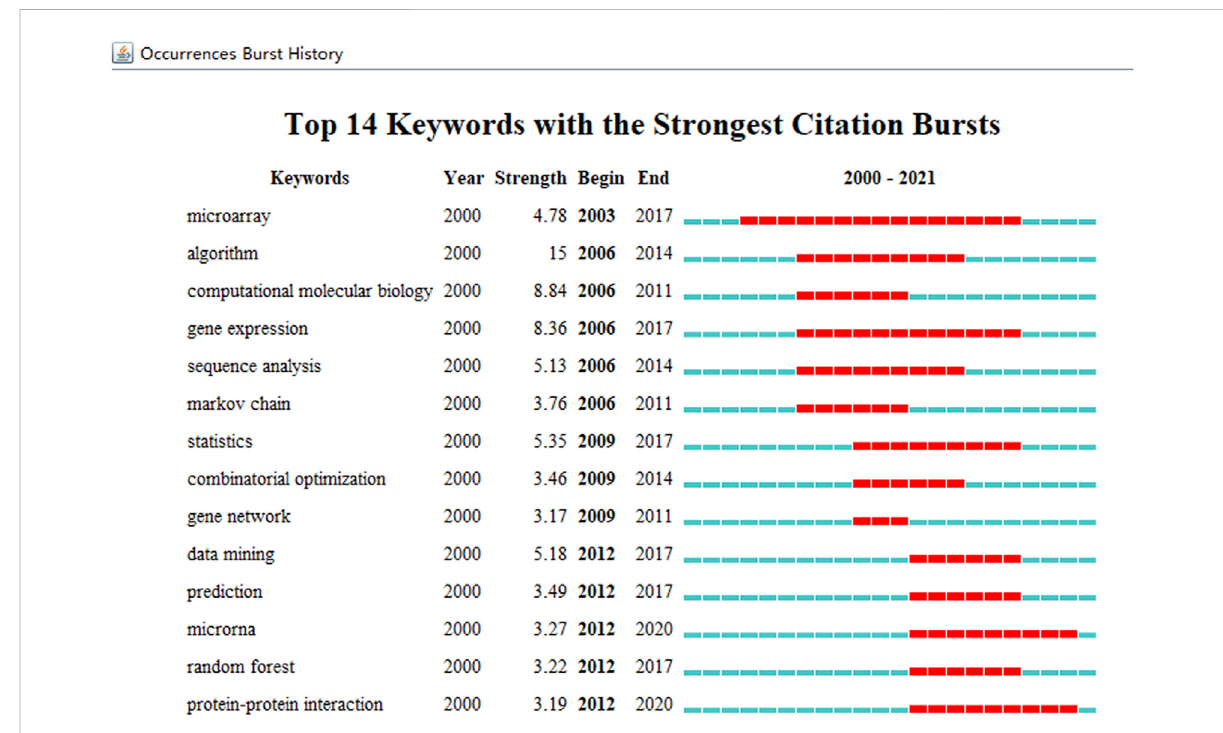
FIGURE 8 The keywords with the strongest citation bursts of publications on ABAM from 2000 to